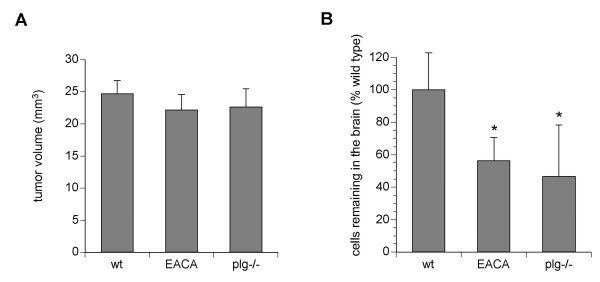
Plasminogen facilitates the process of metastasis but not tumor growth in the brain. A) Ten thousand B16F10 cells were injected in the striatum of 5   wild-type mice (control), 5 plg-/- mice (plg-/-) and 5 wild type mice   treated with EACA (EACA). The mice were sacrificed 12 days after tumor   cell injection and the brains removed to determine the size of the   growing tumor (bars show the standard deviation). No statistically   significant difference between the three groups was observed. B)   Wild-type mice (wt),plg-/- mice and wild type mice treated with EACA   (EACA) were injected with 100,000 125I-deoxyuridine labeled B16F10   cells in the internal carotid artery. They were sacrificed 3 days later   and their brains removed to determine the amount of radioactivity and   compared to the total amount radioactivity injected in these mice. The   bars represent the average of six mice for each group (bars show the   standard deviation). The amount of radioactivity found in the wild type   mice was considered as 100% *p<0.01.